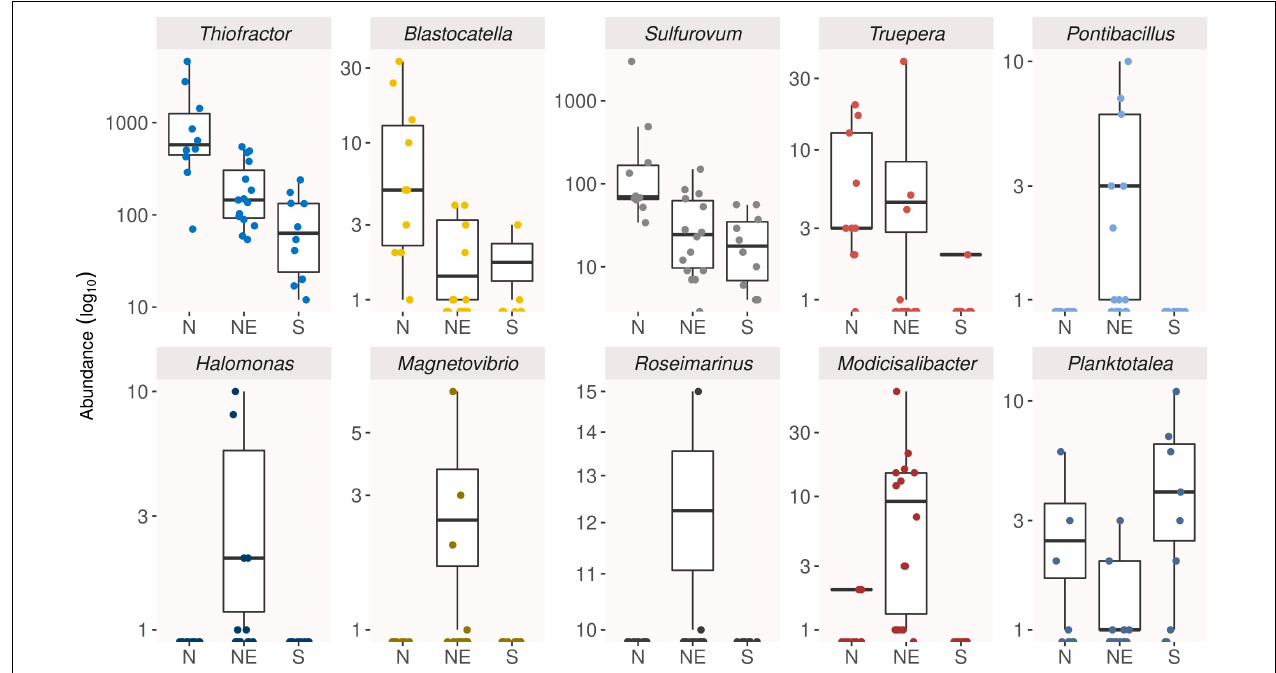
FIGURE 5 | Box plots showing the abundance distribution of the main indicator genera of Rhizophora mangle root-associated soil microbiomes at North (N), Northeast (NE), and South